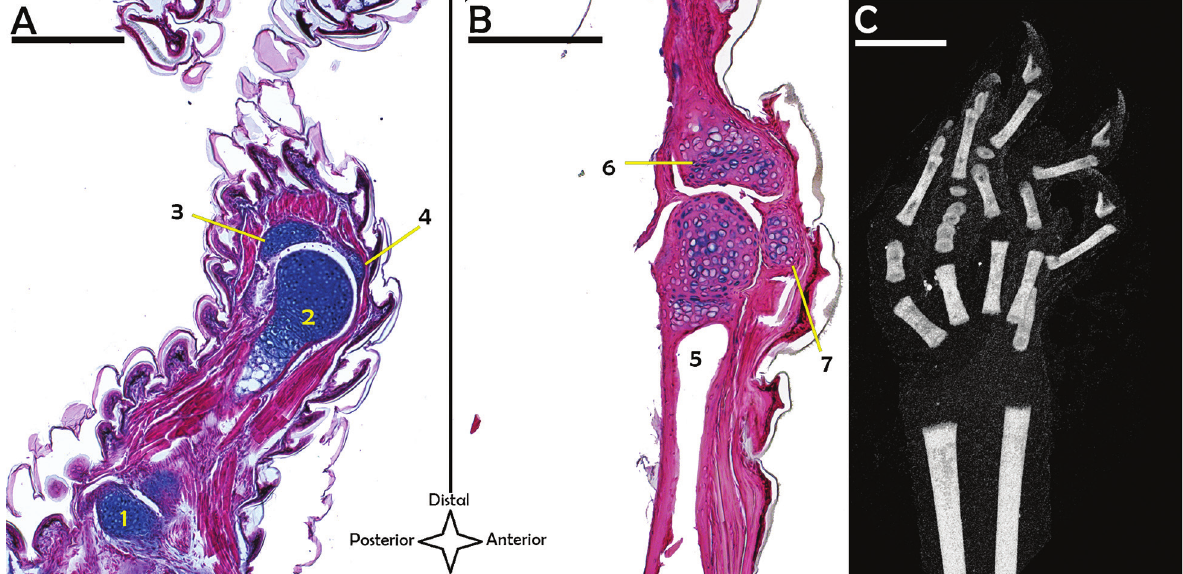
Figure 5. Forelimb of juvenile Hemidactylus , stained with azan (A, B) and scanned by µ CT (C) . (A) and (C) are of the hatchling ZMB 87077 (cross section no. in A is A5_F_13a), and (B) of the juvenile ZMB 87076 (cross section no. A4_F_21a). Note the yet unossified paraphalanges in both. In contrast, reduced phalangeal elements have started ossifying. Radius and ulna are not yet fully ossified, and carpal elements are as yet unossified. Numericals indicate: 1 – trapezium; 2 – metacarpal; 3 – phalanx; 4 – paraphalanx; 5 – metacarpal; 6 – phalanx; 7 – paraphalanx. Scale bars in (A) and (B) equal 200 µ m, and scale bar in (C) is 550 µ